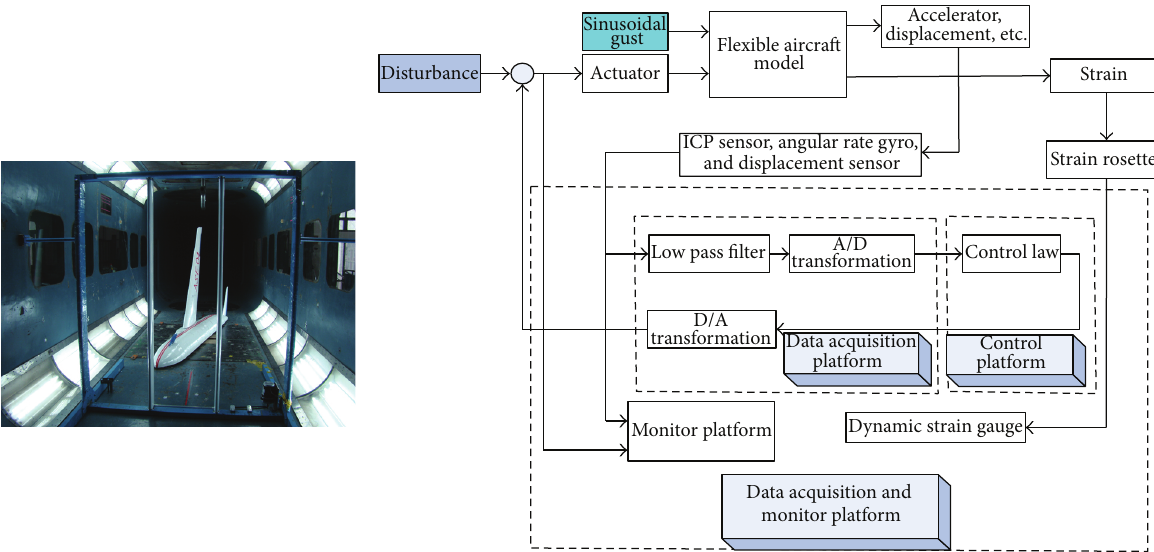
Figure 1: The elastic aircraft model and experimental control